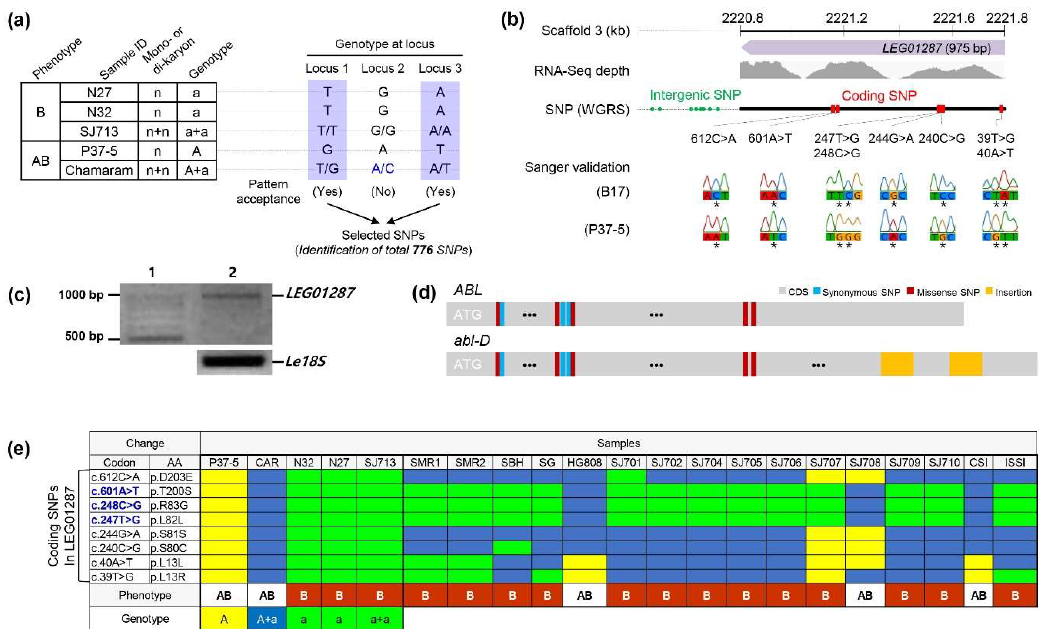
Figure 2. Identification of a dominant abl - D allele associated with abnormal brown film formation. ( a ) Identification of single-nucleotide polymorphisms (SNPs) through comparison of genome sequences from selected strains. A total of 776 SNPs that the allele combination of genotypes “A” and “a” at each loci met the phenotype pattern (A or AB) were identified. The purple-color shaded boxes indicate an allele that is accepted as a valid SNP. ( b ) Schematic structure of the candidate gene responsible for abnormal brown film formation with the locations of predicted SNPs indicated. ( c ) RT-PCR analysis of LEG01287 gene expression. Le18 S was used as an internal control. Lane 1—1 Kb molecular weight marker; Lane 2— Le18 S and LEG01287 PCR products. ( d ) Schematic diagram of ABL (wild-type, upper) and abl - D (mutant type, lower). Polymorphism locations are indicated. The orange-color boxes